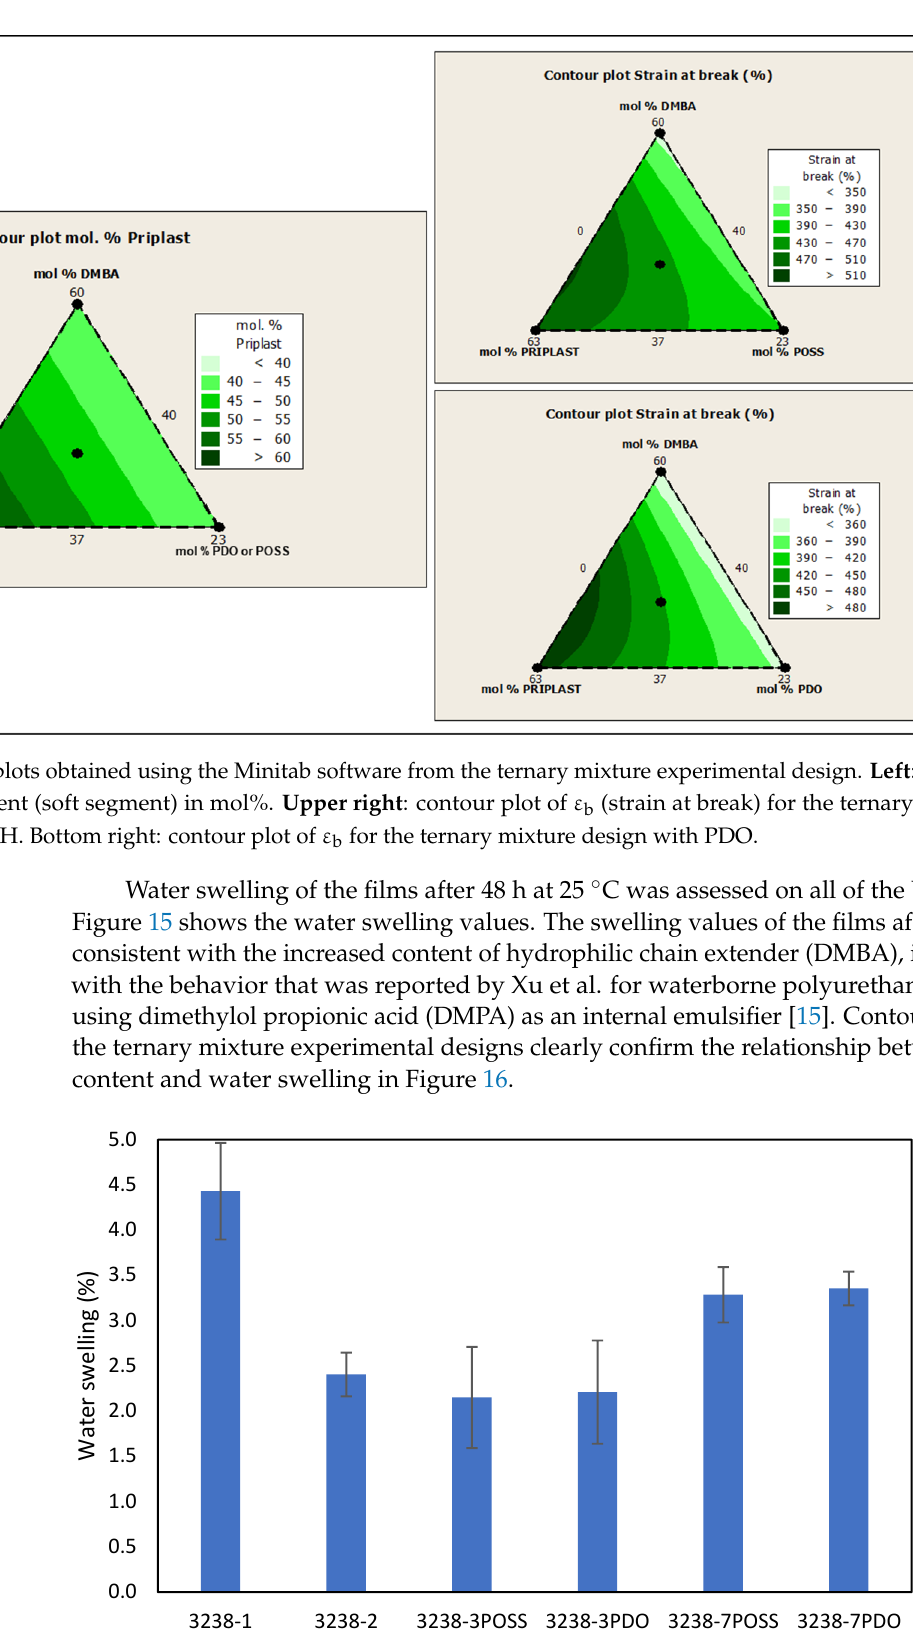
Figure 15. Swelling of WPUD films in water at 25 °C for 48 h.